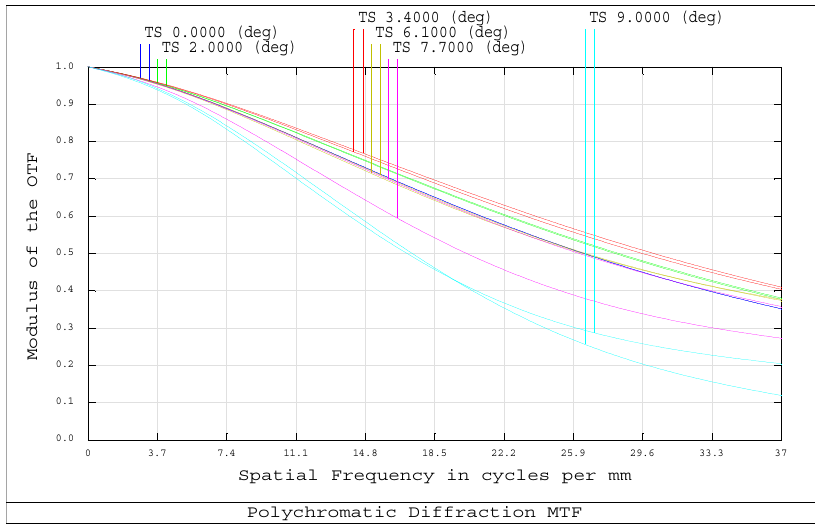
Figure 2. Modulation transfer function.